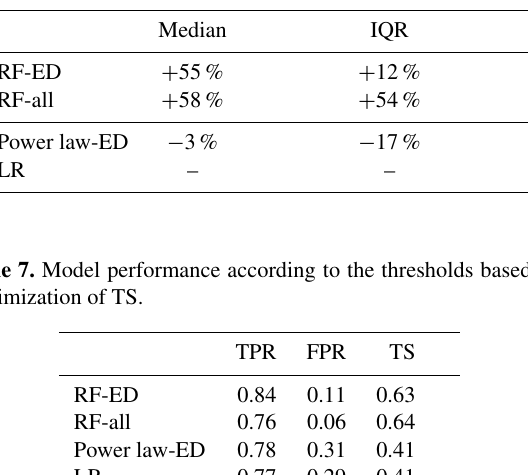
Table 6. Relative difference in TS distribution between the refer- ence model (LR) and the RF-ED, RF-all and ED models at the max- imum sample size examined. Positive values denote an increase in other models relative to LR.